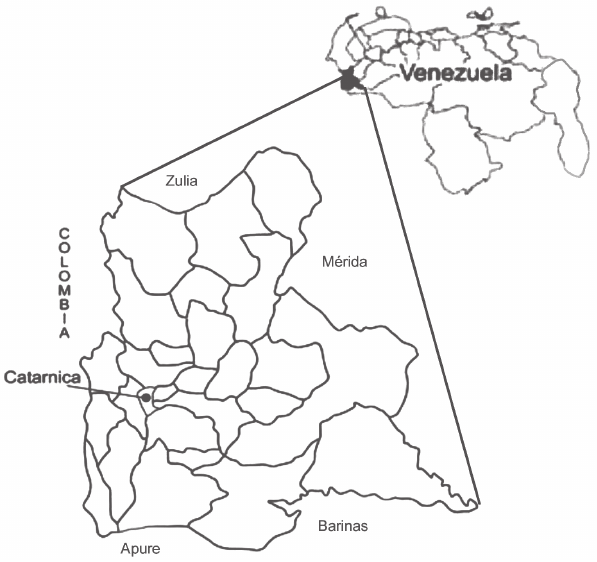
Fig. 1. – Map showing the relative location of the village Catárnica in Táchira State and in